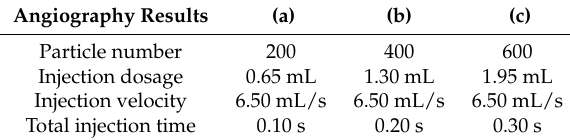
Figure 7. 3D virtual angiography results with various injection dosages. ( a ) Result with an injection dosage 0.65 mL, and the total injection time 0.10 s; ( b ) Result with an injection dosage 0.65 mL, and the total injection time 0.20 s; ( c ) Result with an injection dosage 1.95 mL, and the total injection time 0.30 s. Table 1. Injection conditions with various injection dosages.